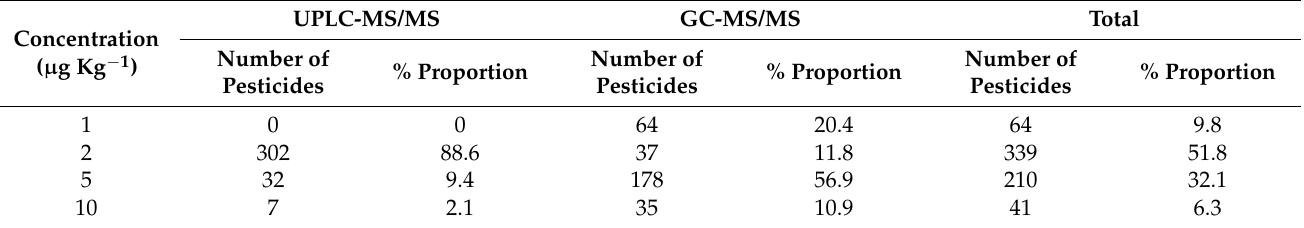
Table 1. Limits of quantification (recovery in the range of 70–120% and relative standard deviation ≤ 20%) at different levels.